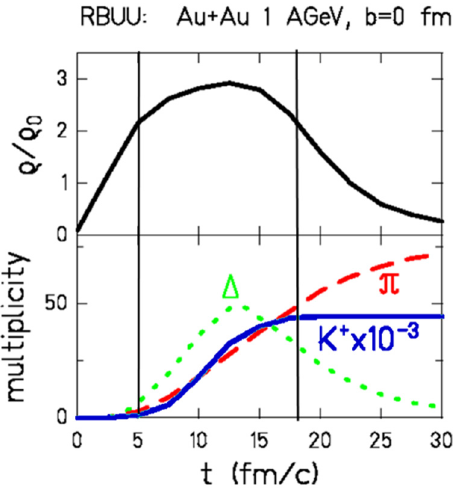
Figure 13. Upper panel: Density in the reaction volume as function of time for a central Au+Au collision at 1A GeV as calculated by a RBUU transport model. Lower panel: Multiplicities of produced ∆ resonances (green dotted line), pions (red dashed line) and K + mesons (blue line) as functions of time.